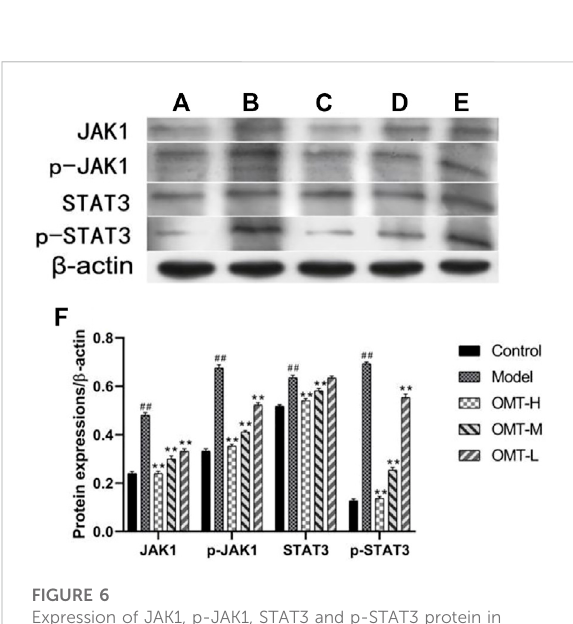
Expression of JAK1, p-JAK1, STAT3 and p-STAT3 protein in skintissue( β -actinimageforcontrolwerethesameinFigure5and Figure 6). (A) Normal control group; (B) Model group. (C) OMT-H group. (D) OMT-Mgroup. (E) OMT-Lgroup. (F) Statisticaldata ofexpressionofJAK1, p-JAK1, STAT3 and p-STAT3 proteinineach group. ( ## , p < .01, vs. Control group; **, p < .01, vs. model group).